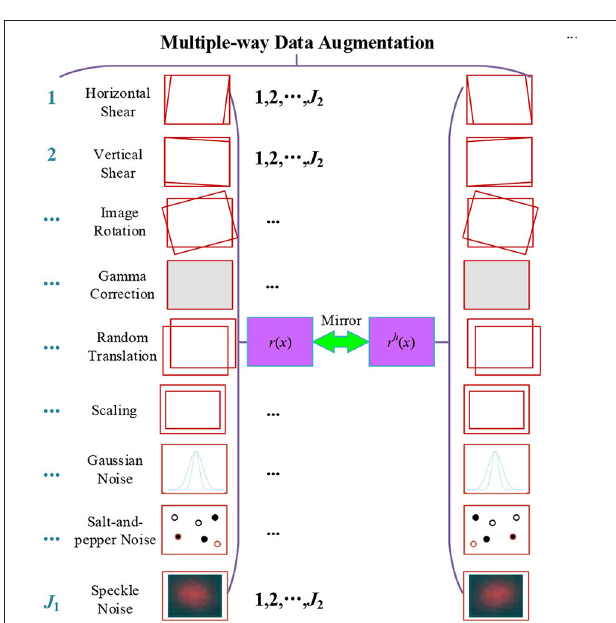
FIGURE 11 | Diagram of 18-way DA.